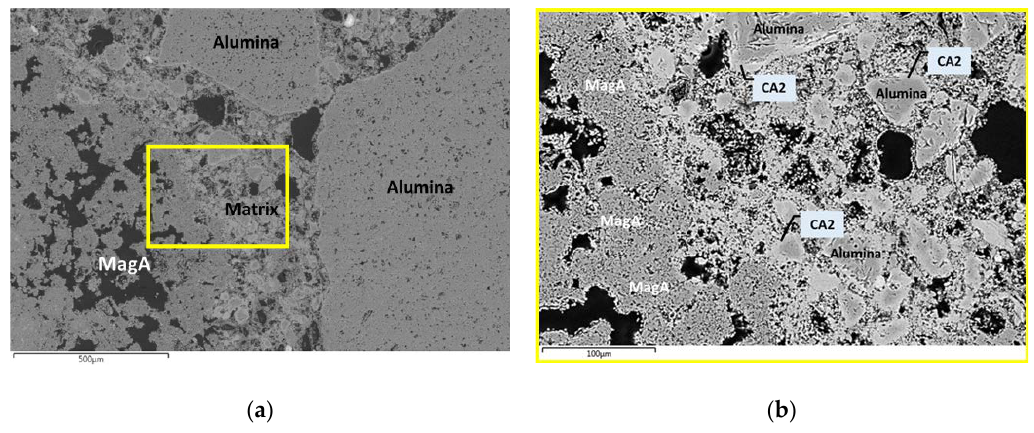
Figure 11. Microstructure of non-penetrated Zone f about 33 mm from hot side ( a ) and zoom into the indicated matrix area ( b ).